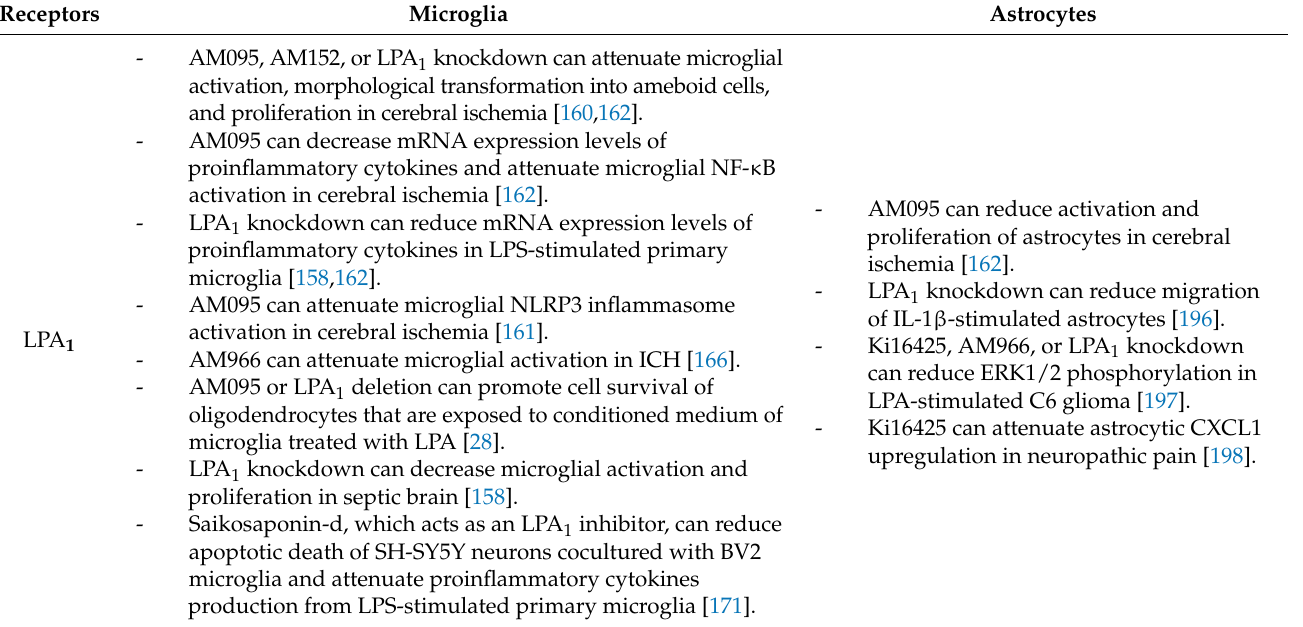
Table 2. LPA receptors in neuroglial activation and their neuroinflammatory responses. N/A: not available. Receptors Microglia